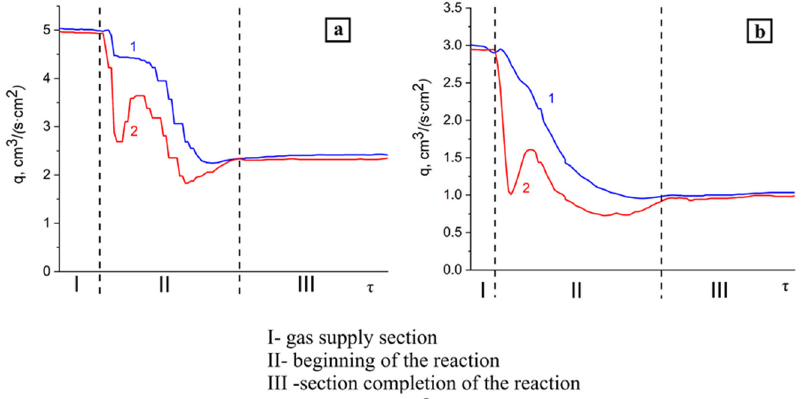
Figure 6. Profile patterns of the specific flow rate of the nitrogen–argon mixture obtained during combustion of the (70% AlN + 30% Al) sample. Parameters: Ar = 15%, ( a ) q = 5.0 cm 3 /(s∙cm 2 ), ( b ) q = 3.0 cm 3 /(s∙cm 2 ), 1–reactor inlet, 2–reactor outlet.